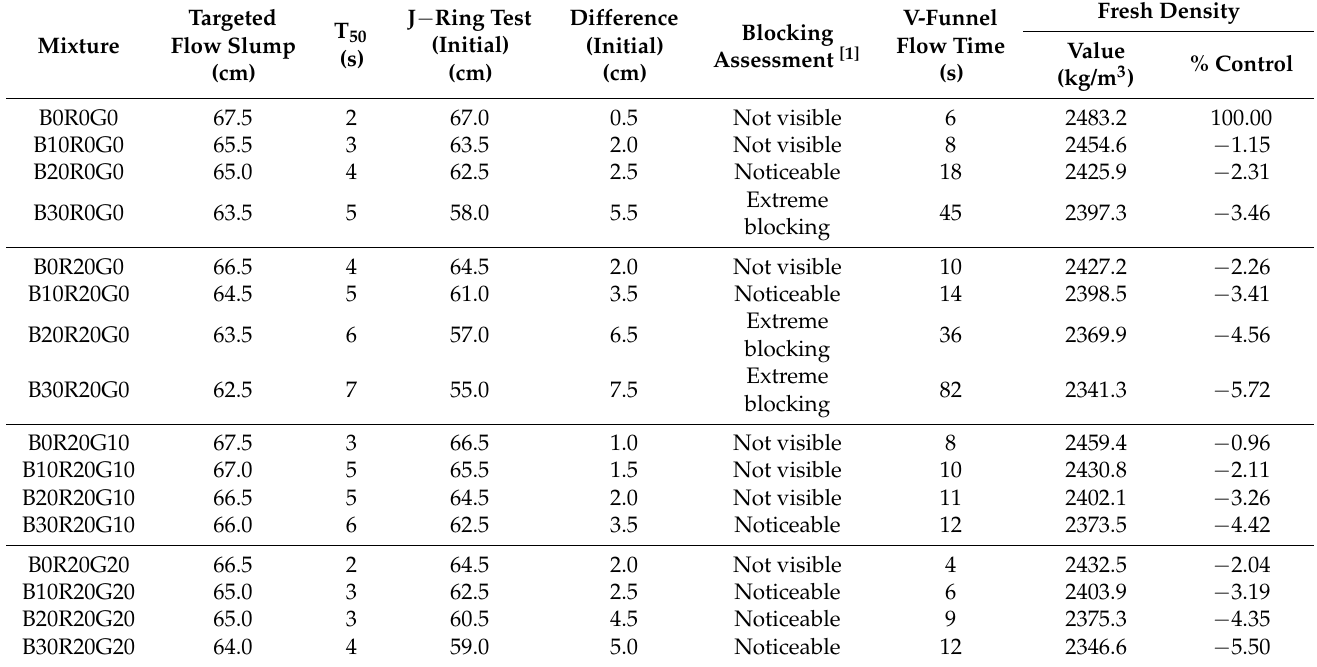
Table 4. Workability of the gSCC